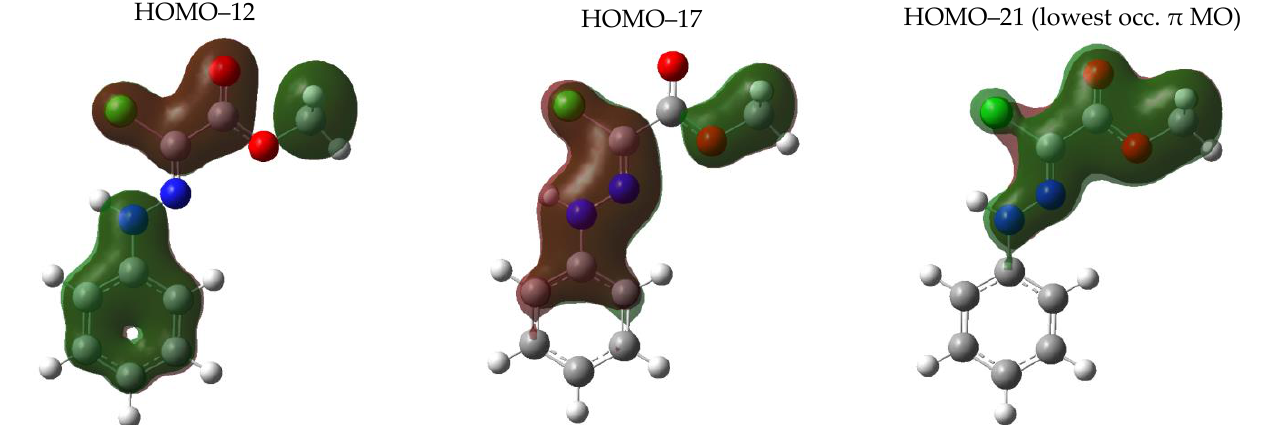
bond character of the N–N bond.